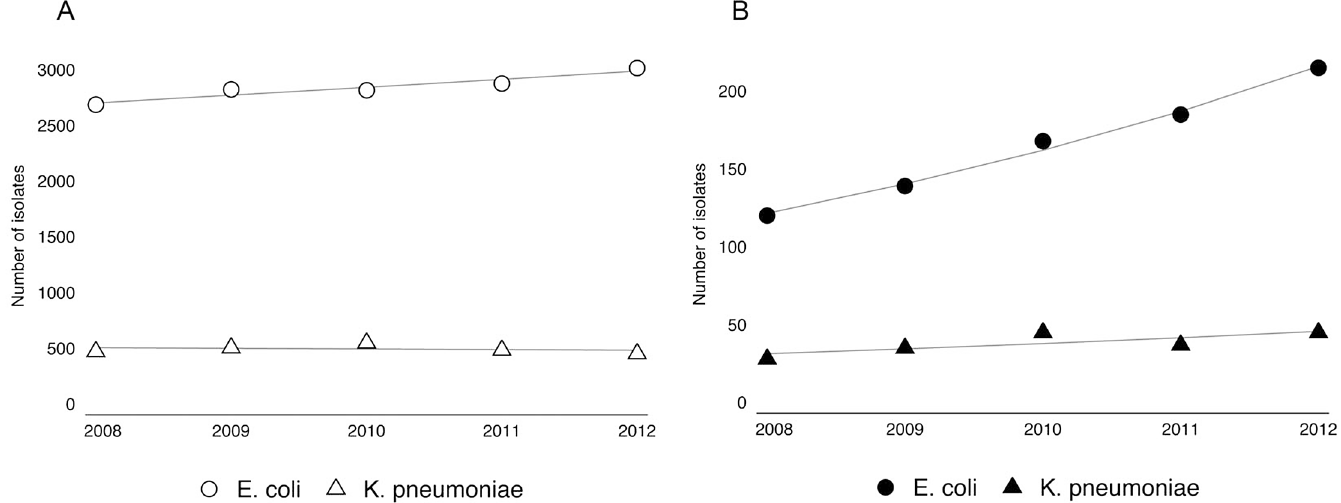
Fig 1. The rate of bloodstream infections by Escherichia coli and Klebsiella pneumoniae (A) and the rate of bloodstream infections by extended- spectrum cephalosporin-resistant Escherichia coli and Klebsiella pneumoniae (B) from 2008 – 2012, ISIS-AR, the Netherlands, adjusted for patient characteristics, including age, gender, patient setting and geographic region. The plots show the point-estimates and log-linear trends generated by a Poisson regression with robust standard